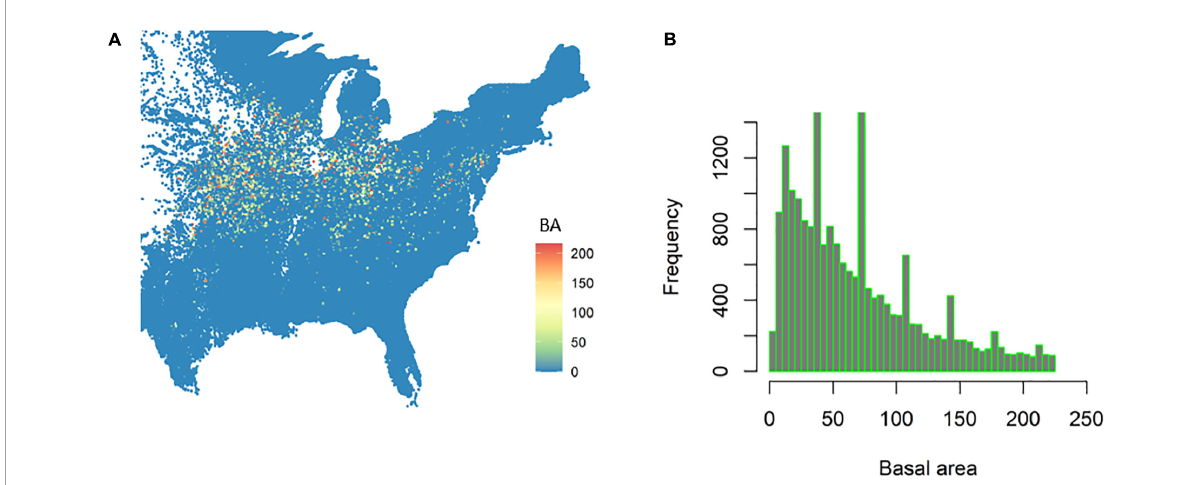
FIGURE3 The distribution of black walnut in the United States (A) and associated basal area (BA, m 2 /ha) frequency distribution (B) .